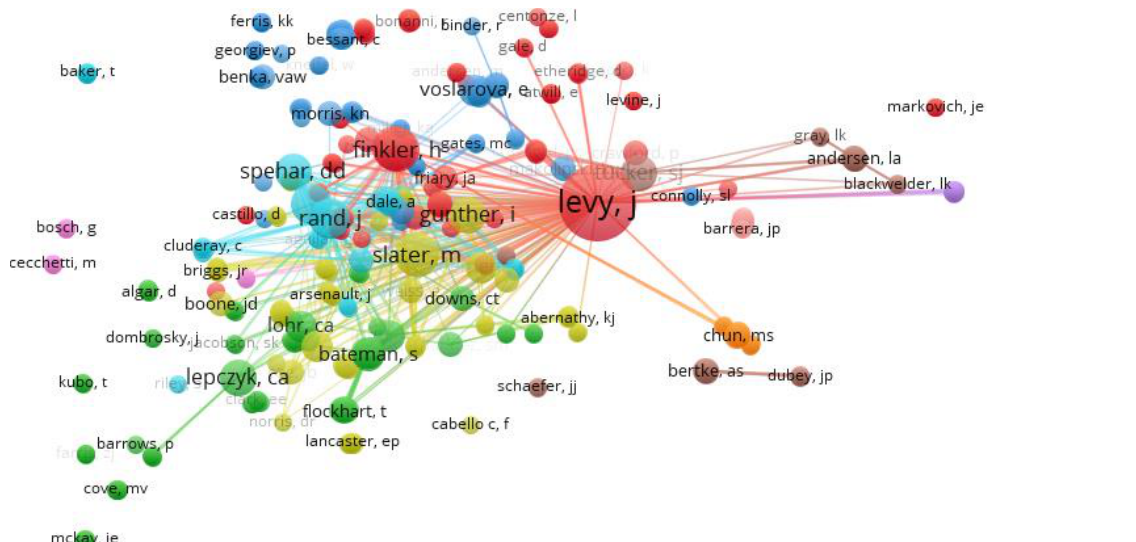
Figure 4. Networks for 398 authors publishing on TNR cat management showing bibliographic coupling links between authors. Here, each node (circle) represents an author. The size of the node represents the number of papers published by each author and the thickness of the lines represents bibliometric coupling, where the strength is determined by the number of shared citations between authors.